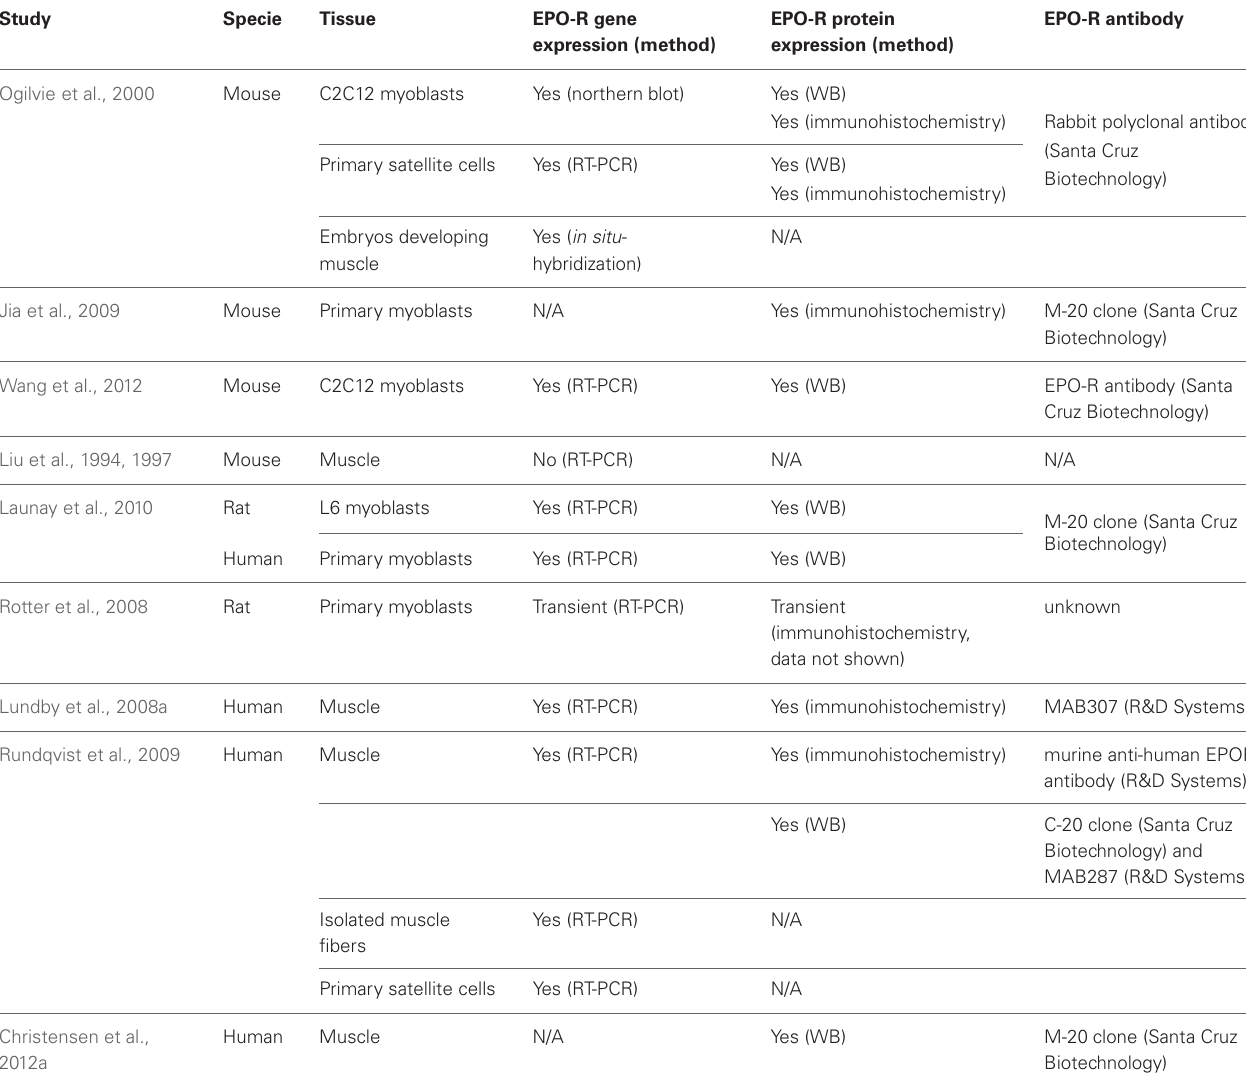
Table 1 | Detectability of the EPO-R in skeletal